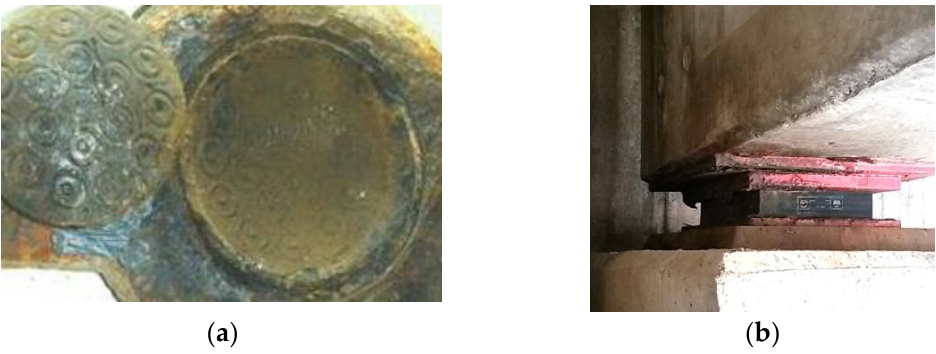
Figure 2. Corrosion of bearing supports: ( a ) high-strength brass friction material rust; ( b ) corrosion of bearing supports due to rust.